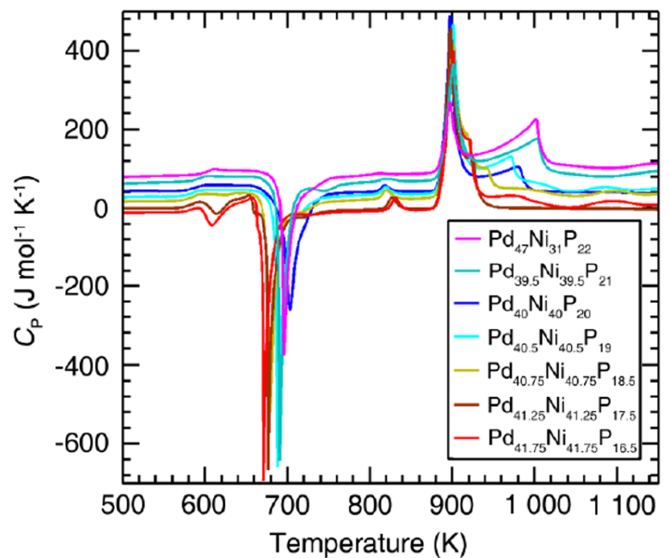
Figure 8. DSC data during heating for Pd-Ni-P metallic glasses. The heating rate is 20 K/min. The curves have been shifted vertically for clarity. Reprinted from ref. [47], Figure S3.